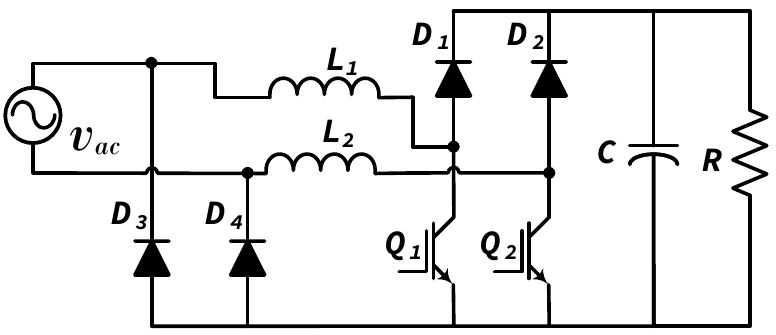
Figure 10. Semi-bridgeless boost converter with clamped